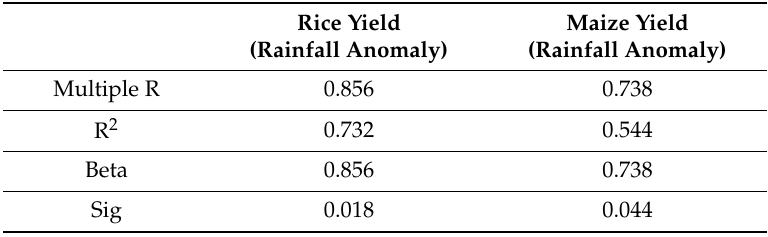
Table 2. Multiple linear regression analysis for maize and rice yield.